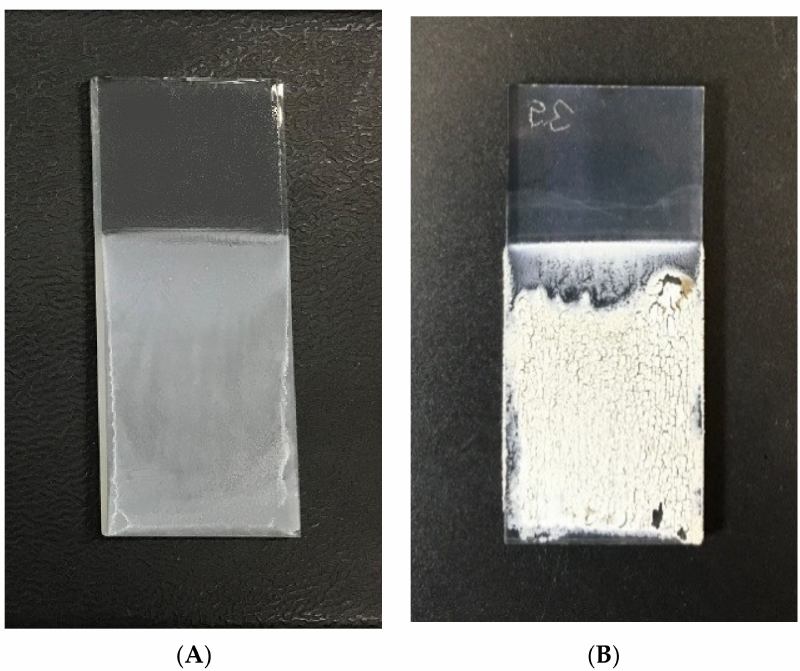
Figure 2. Top view on g- C 3 N 4 layers. The suspension prepared from US-treated g-C 3 N 4 after one week of sedimentation ( A ) and a fresh suspension ( B ) were used for electrophoretic deposition (applied potential, 50 V; time, 30 min).